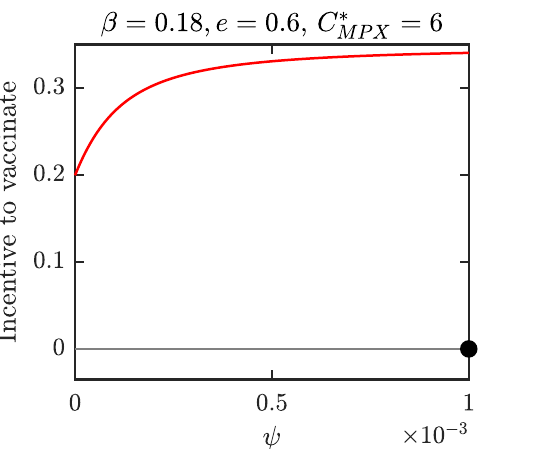
Fig 15. The incentive function for the parameters in the red region of Fig 10. Full black circle is the CSNE. There is no ψ . Unless varied or otherwise specified, the parameters are as in Table HI